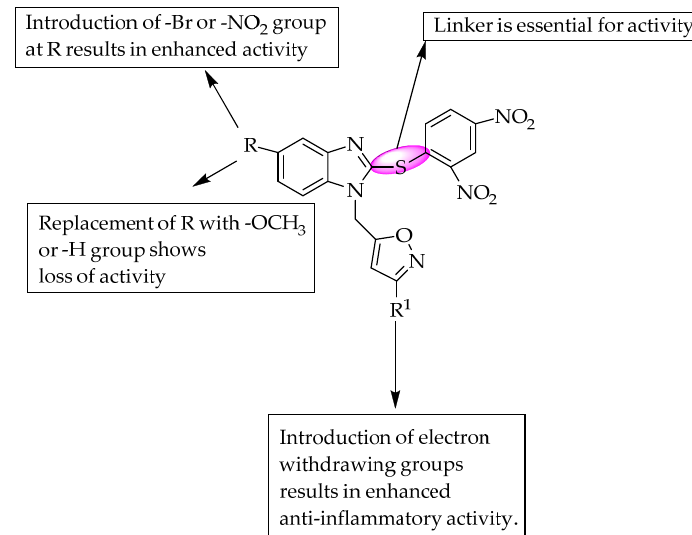
Figure 29. SARs of 3,5-disubstituted isoxazole at N1 of benzimidazole.